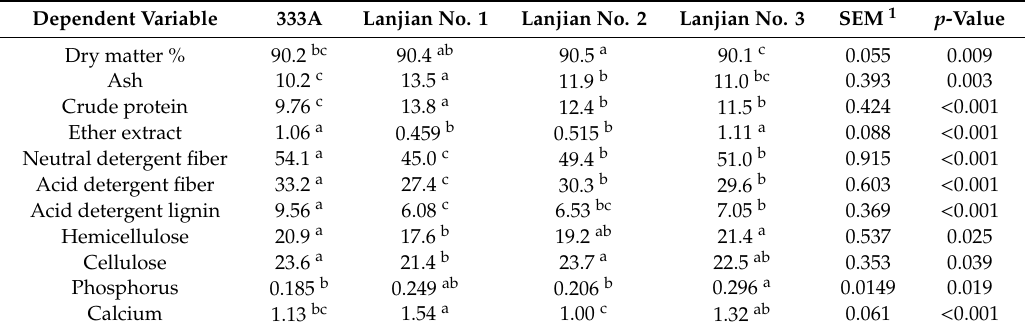
Table 3. Influence of variety on chemical composition (% dry matter unless stated otherwise) of straw in four common vetch varieties.